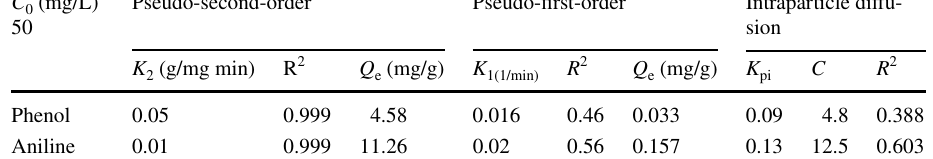
Pseudo-second-order Pseudo-first-order